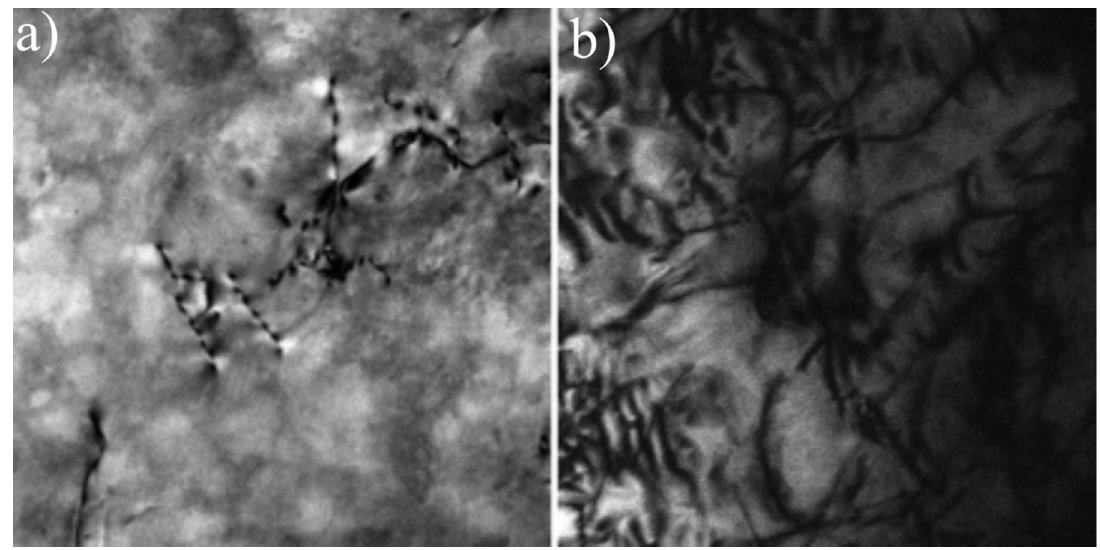
Figure 8. TEM images showing dislocation structures and densities in ( a ) HH sample, and ( b ) LH sample. Table 5. EBSD data in conjunction with peak temperatures of the joints welded at the conditions of experiment numbers 2 (high heat input) and 5 (low heat input).